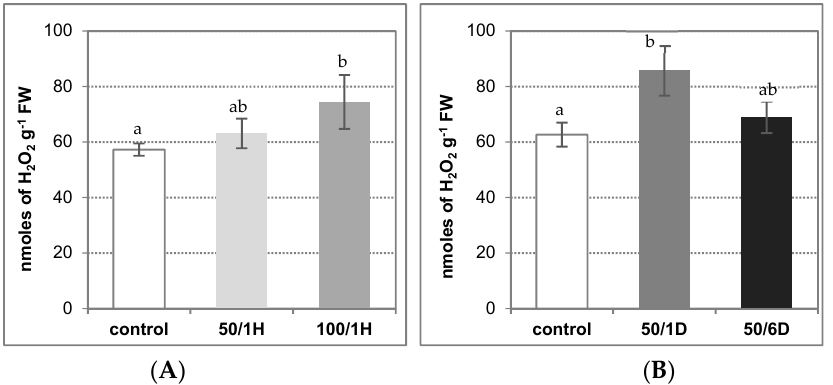
Figure 1. H 2 O 2 level in roots of cucumber seedlings treated with: ( A ) 50 mM or 100 mM NaCl for 1 h (50/1H and 100/1H, respectively); ( B ) 50 mM NaCl for 1 or 6 days (50/1D and 50/6D, respectively). The H 2 O 2 level was determined in the roots as described in Materials and Methods. The presented results are the means ± SD of three independent experiments, each run in triplicate. Different letters show different homogeneous groups of means calculated by Duncan’s multiple range test (significant at p < 0.05).